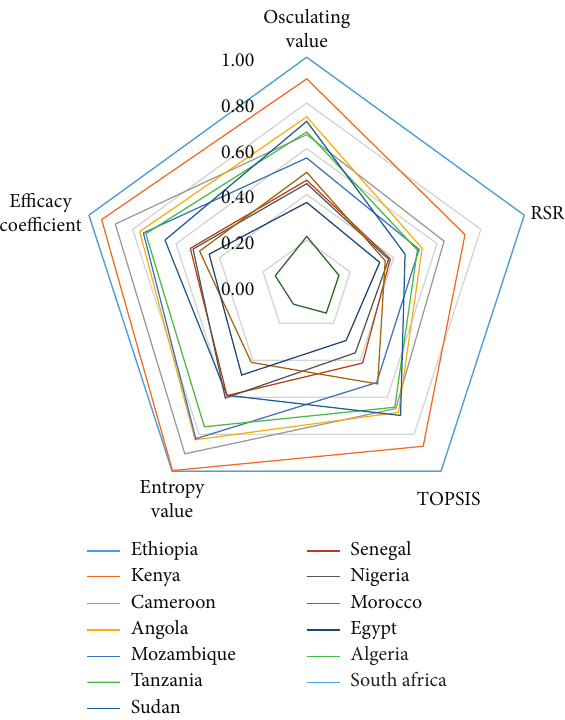
Figure 9: Matching effect picture of Chinese power companies in Africa. Table 8: Matching indicators value of Chinese power companies in Africa.